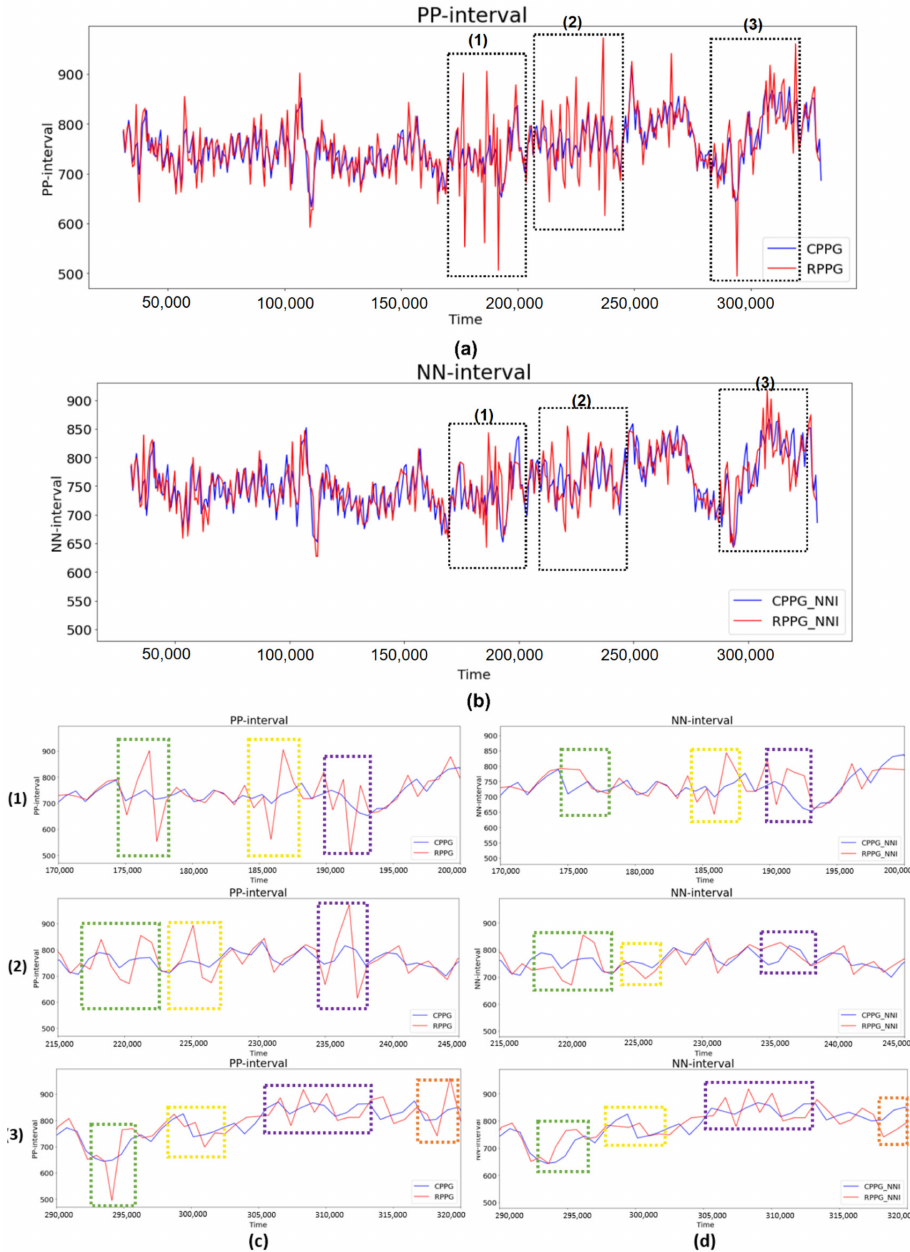
Figure 8. Comparison of the range ((1) to (3)) showing relatively large fluctuations in the RPPG PPI when the PPI of the RPPG and the PPI of the CPPG of subject 5 were compared. ( a ) Total PPI,